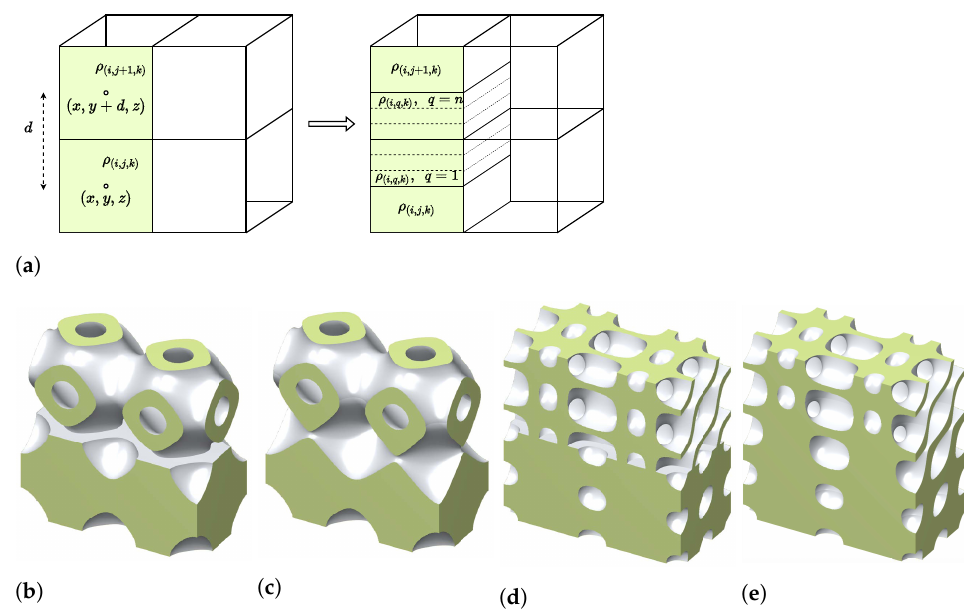
Figure 7. Interface smoothing of adjacent microstructures with variant design-parameter ( ρ e ). ( a ) Den- sity filter with linear interpolation in y -directions. ( b ) F P before smoothing. ( c ) F P after smoothing. ( d ) F 1 before smoothing. ( e ) F 1 after smoothing.